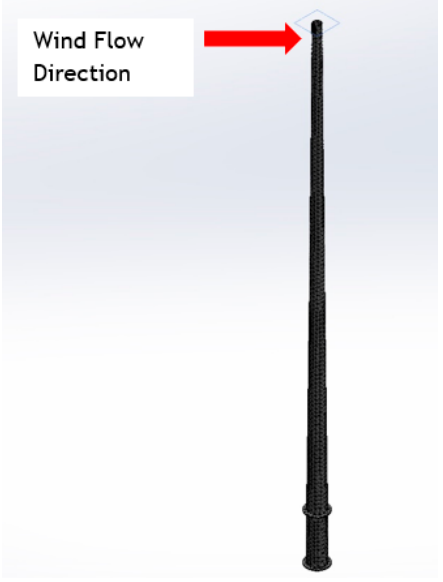
Figure 14. FE model shows the wind flow direction on